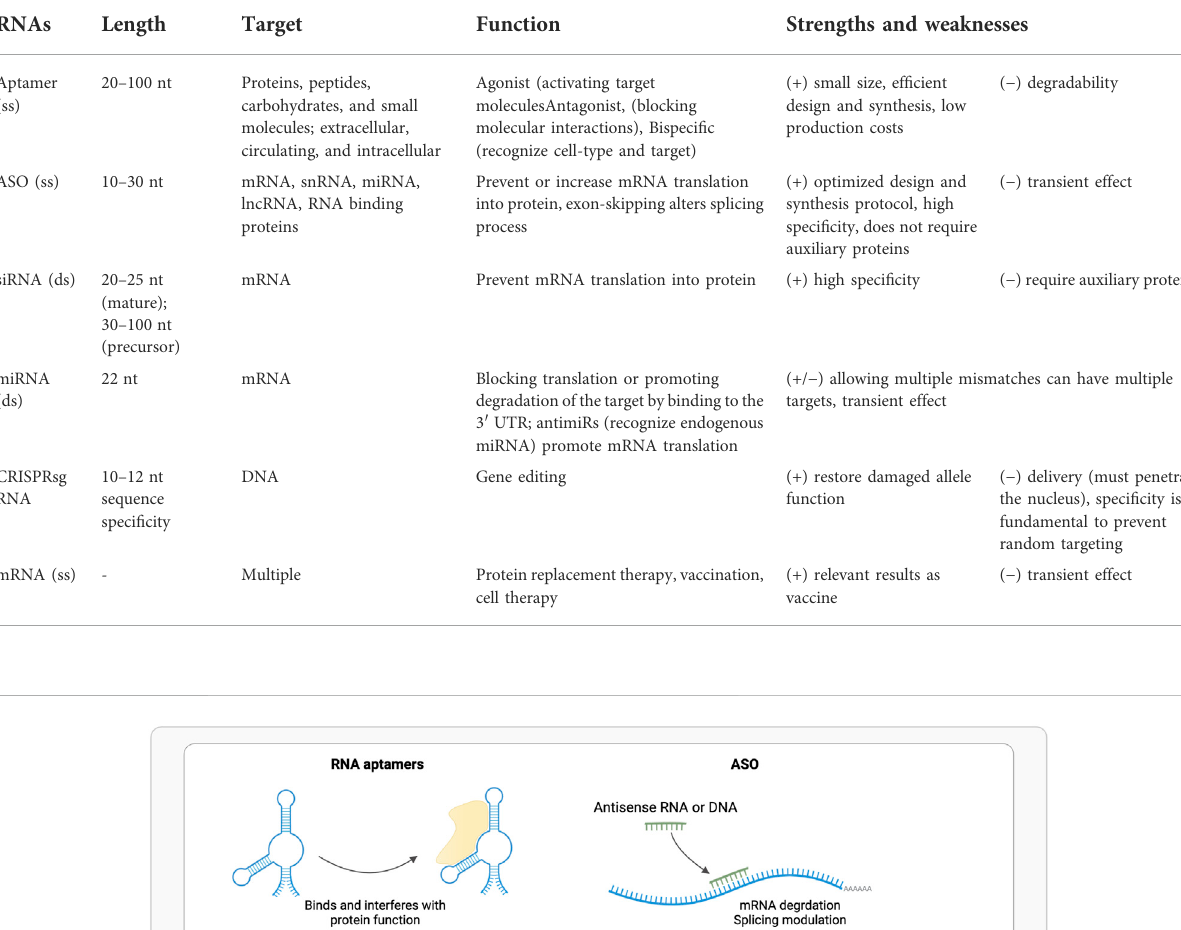
TABLE 1 Summary of therapeutic RNAs characteristics (ss, single strand; ds, double strand).